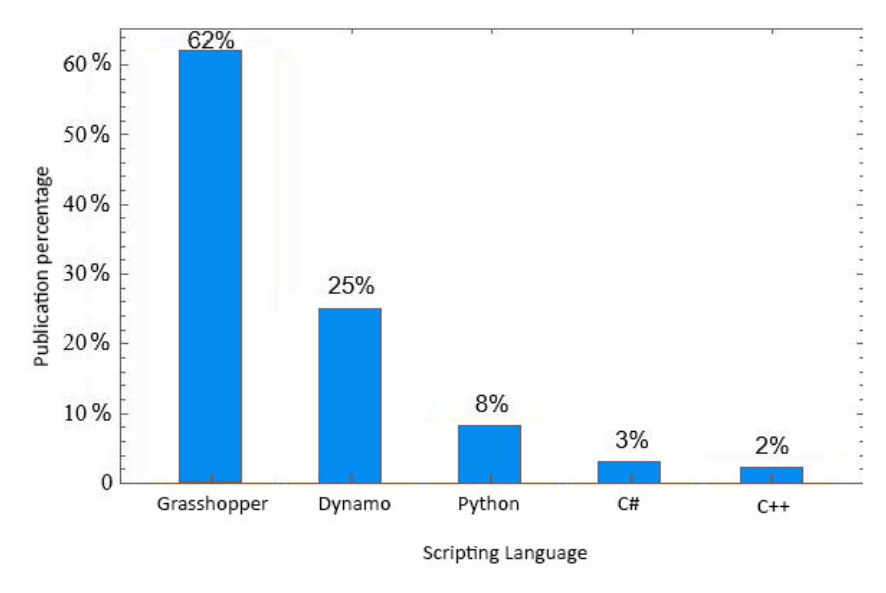
Figure 7 The quantity of articles classified by programming